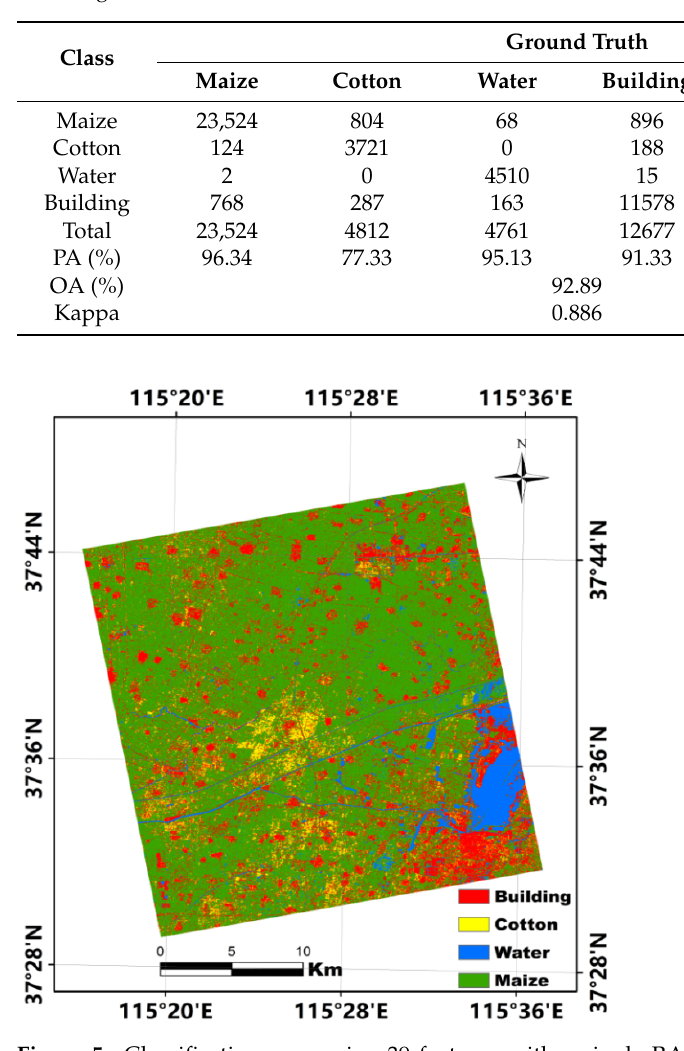
Table 7. Confusion matrix of the 4 land-cover types classified using 117 features and the random forest algorithm.